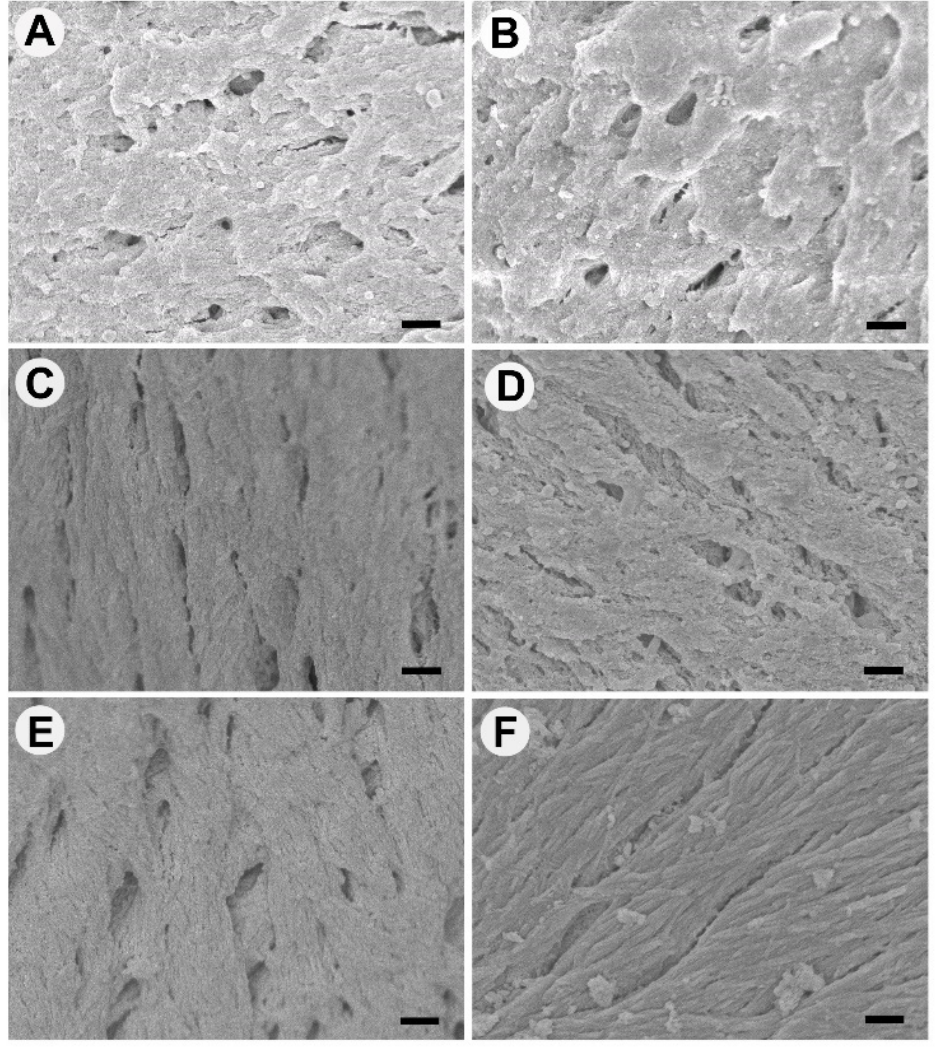
Figure 1. Scanning electron microscopy images of the surfaces of bone scaffolds heat-treated at ( A ) 100 °C, ( B ) 130 °C, ( C ) 160 °C, ( D ) 190 °C, ( E ) 220 °C, ( F ) Bio-Oss ® . Scale bar = 1 µm. Representative images of N = 4.